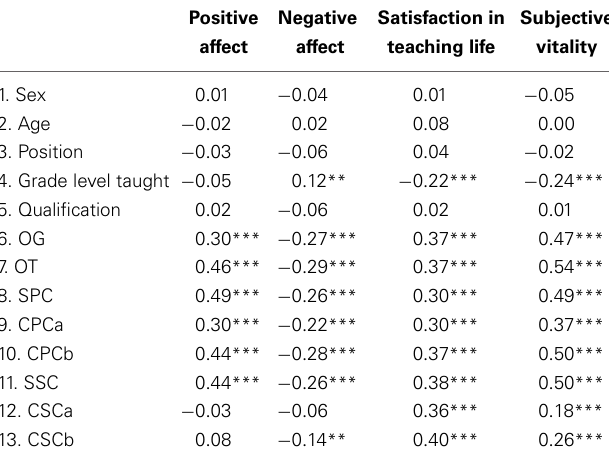
Table 3B | Bivariate correlations between the facets of subjective well-being and the major study variables.